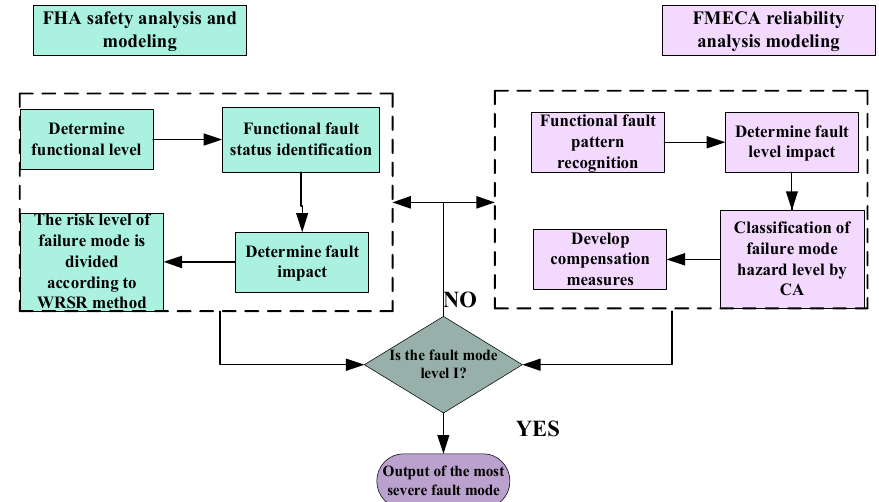
Figure 9. A schematic diagram of the FMECA–FHA integrated model.